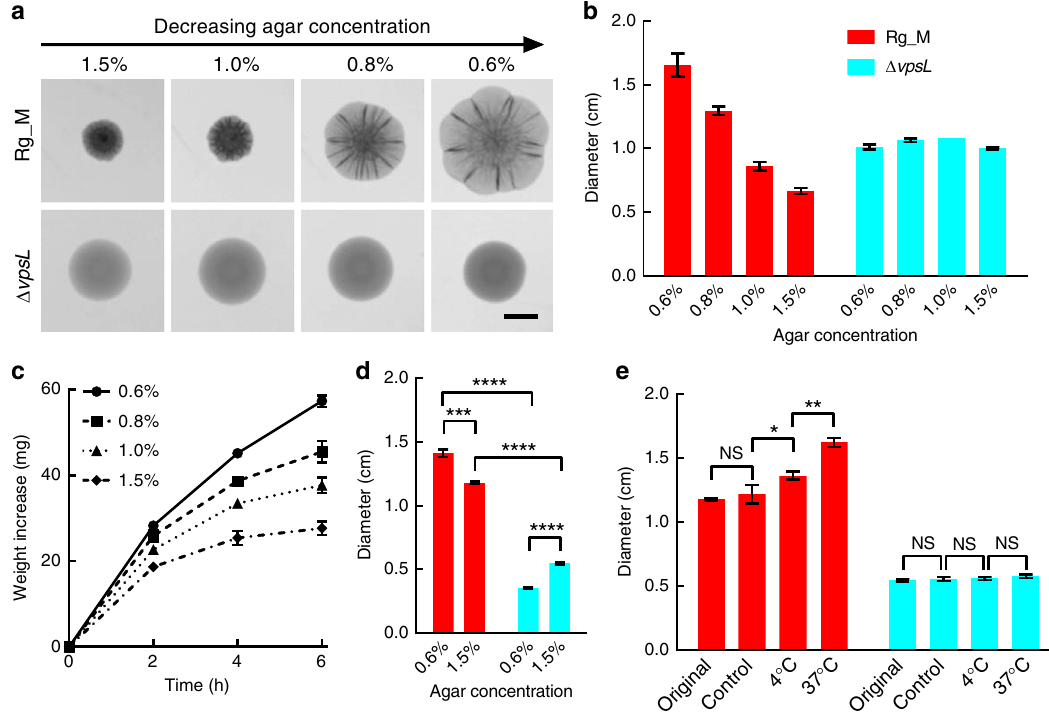
Fig. 1 Osmotic pressure drives V. cholerae colony expansion. a Representative images of colony bio fi lms of the rugose (Rg_M) and EPS − ( Δ vpsL ) V. cholerae strains grown for 2 days on LB medium containing the designated percentages of agar. Scale bar : 0.5 cm. b Colony bio fi lm diameter as a function of agar concentration (rugose (Rg_M: red ) and EPS − ( Δ vpsL : cyan )). c To mimic the swelling effect that occurs in colonies exposed to osmotic pressure changes, 20 μ L liquid droplets of LB containing 15% dextran (~2000 kDa) were placed on semipermeable membranes on top of LB medium solidi fi ed with the designated concentrations of agar. Increases in the droplet weight were measured over time. d Diameters of 4-day-old colony bio fi lms of Rg_M ( red ) and Δ vpsL ( cyan ) strains grown on semipermeable membranes placed on LB medium solidi fi ed with the speci fi ed percentages of agar. Unpaired t -tests with Welch ’ s correction were performed for statistical analyses. e To differentiate the contribution of growth from that of passive swelling during colony expansion, Rg_M ( red ) and Δ vpsL ( cyan ) colonies were initially grown for 4 days on semipermeable membranes on top of LB medium solidi fi ed by 1.5% agar at 37 °C (denoted Original). The membranes containing the colonies were subsequently fl oated on LB liquid medium overnight at 4 or at 37 °C. To control for growth, a separate set of plates containing membranes with colonies that had been grown for 4 days were held at 4 °C overnight (denoted Control). In all cases, the diameters of the colonies were measured after 20 h. Paired t -tests were performed for statistical analyses. NS denotes not signi fi cant; *denotes P < 0.05, **denotes P < 0.01, ***denotes P < 0.001, and ****denotes P < 0.0001. Error bars correspond to standard deviations